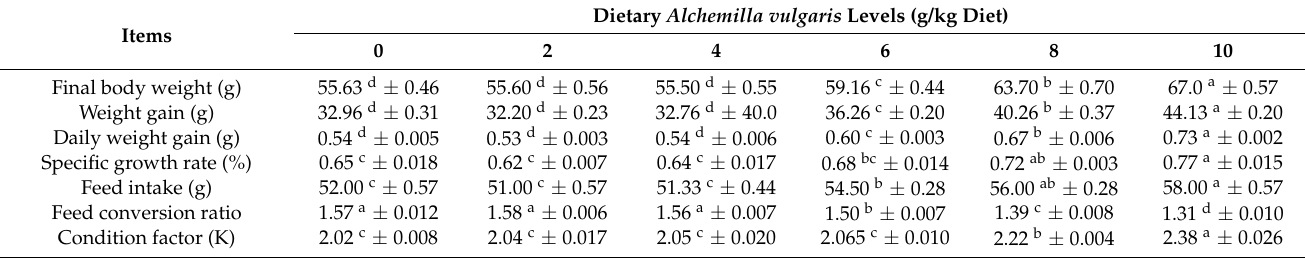
Table 2. Effect of Alchemilla vulgaris dietary supplementation on growth performance and feed utilization of O. niloticus .